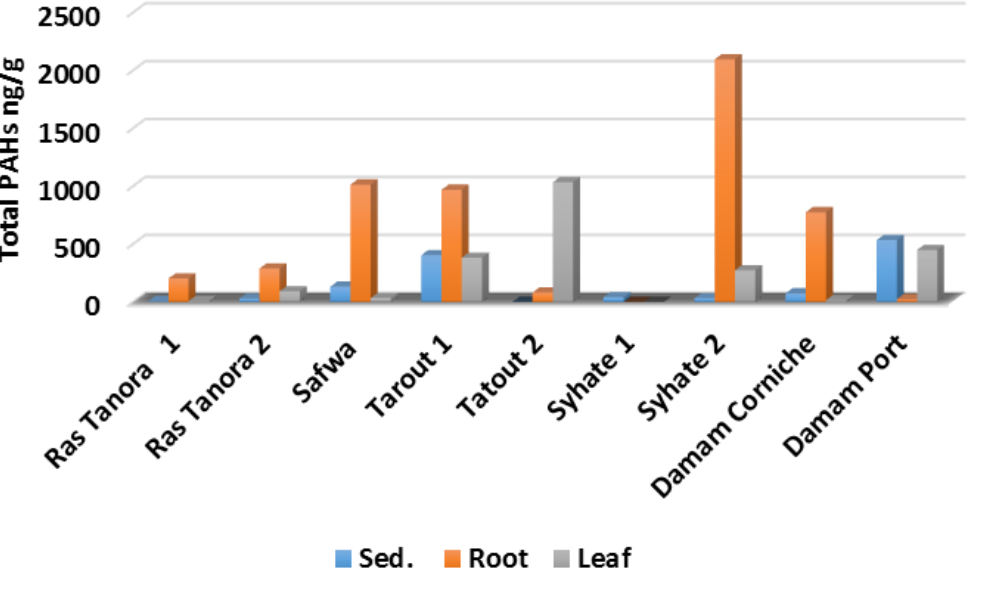
Figure 2: Total PAH concentrations (ng/g) for sediment, roots and leaf in the nine sites of the studied mangrove stands along Arabian